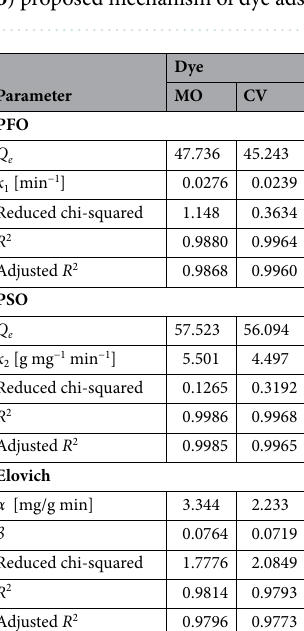
Figure 6. ( a ) Kinetics data of MO and CV adsorption process at their optimum solution pH predicted by non- linear kinetics models at C